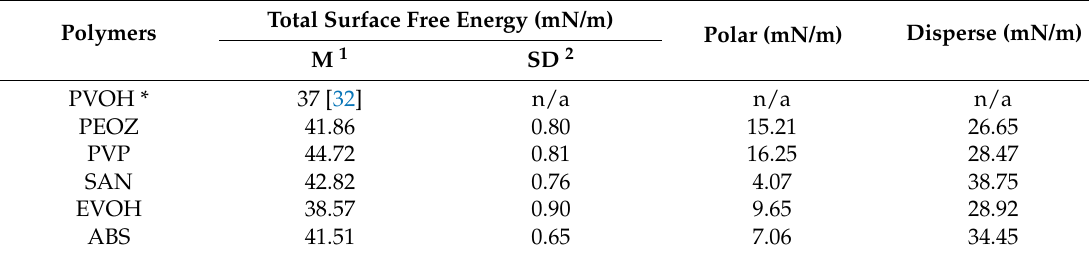
Table 3. Surface free energy of the bulk